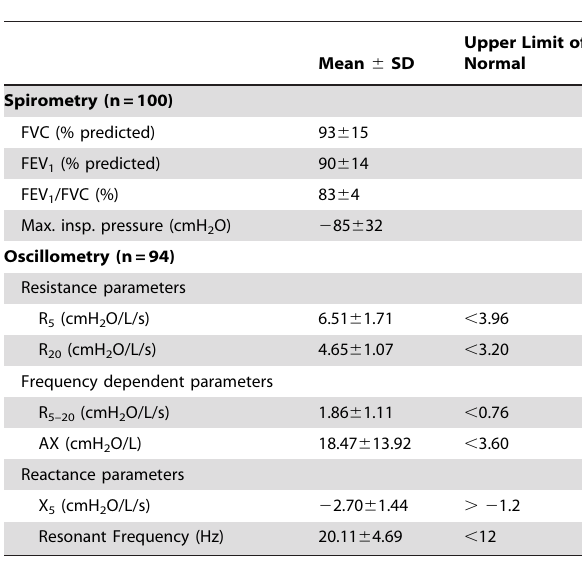
Table 1. Clinical Characteristics (n=100).